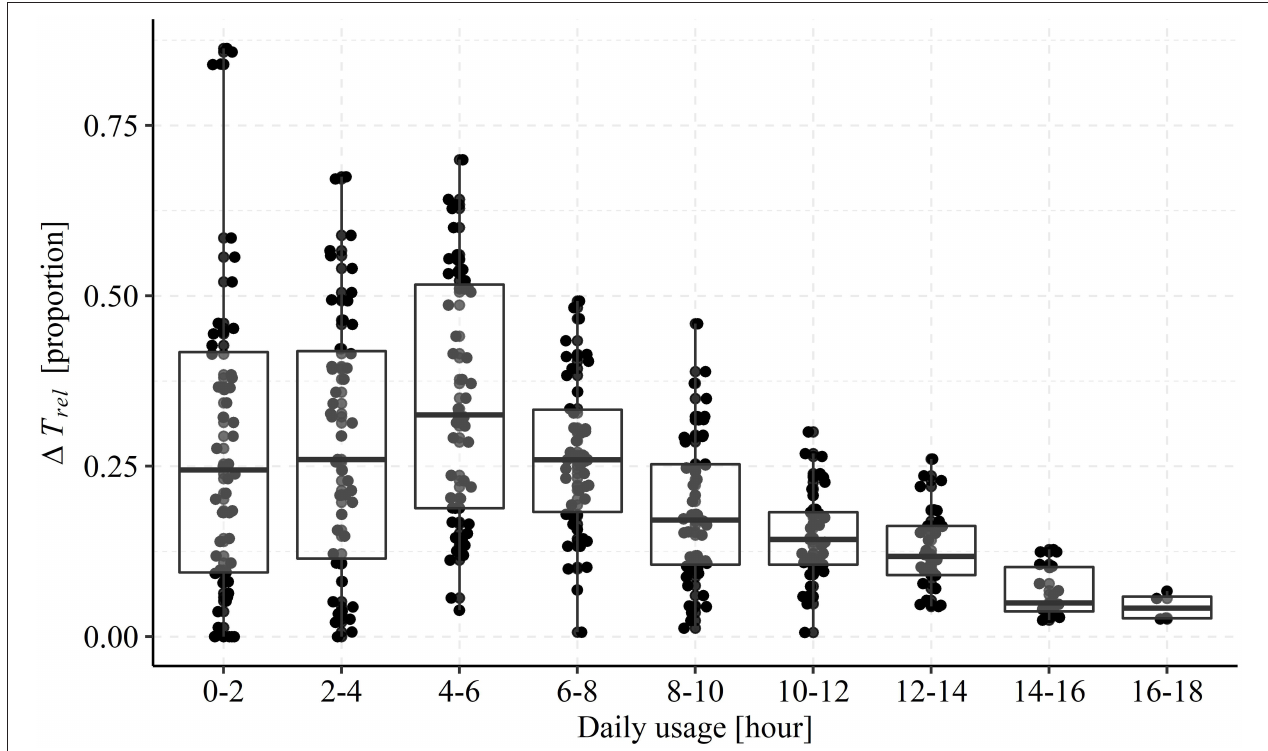
FIGURE 6 | Boxplots and single observations of mean relative difference in usage estimates stratified by the true daily on-time. Each point represents the mean relative difference ( 1 T rel ) for one participant across all days registered with a total on-time falling into the bins on the x-axis. Each box encapsulates the interquartile range (25th percentile to 75th percentile) and the horizontal line represents the median. The whiskers extend to the largest value within 1.5 times the interquartile range above the 75th percentile (top) and smallest value within 1.5 times the interquartile range below the 25th percentile